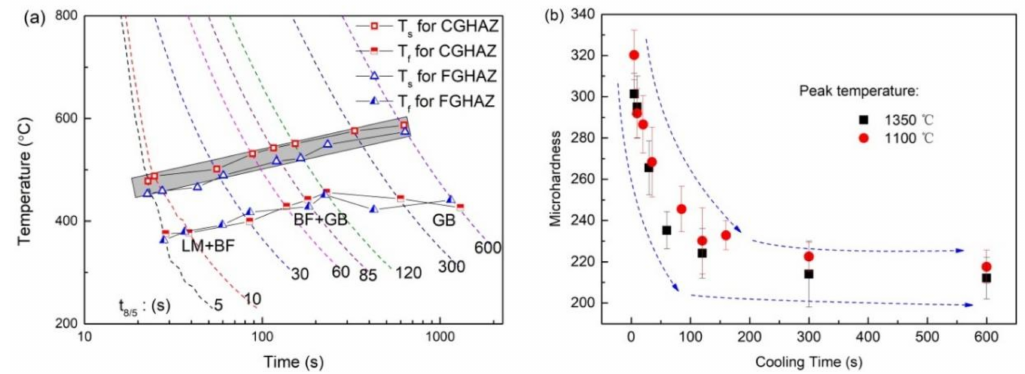
Figure 2. ( a ) Continuous cooling transformation (CCT) diagrams with different peak temperatures and ( b ) the change of Vickers hardness as a function of cooling time (CGHAZ: coarse grained heat-affected zone, FGHAZ: fine grained HAZ, LM: lath martensite, BF: bainitic ferrite, GB: granular